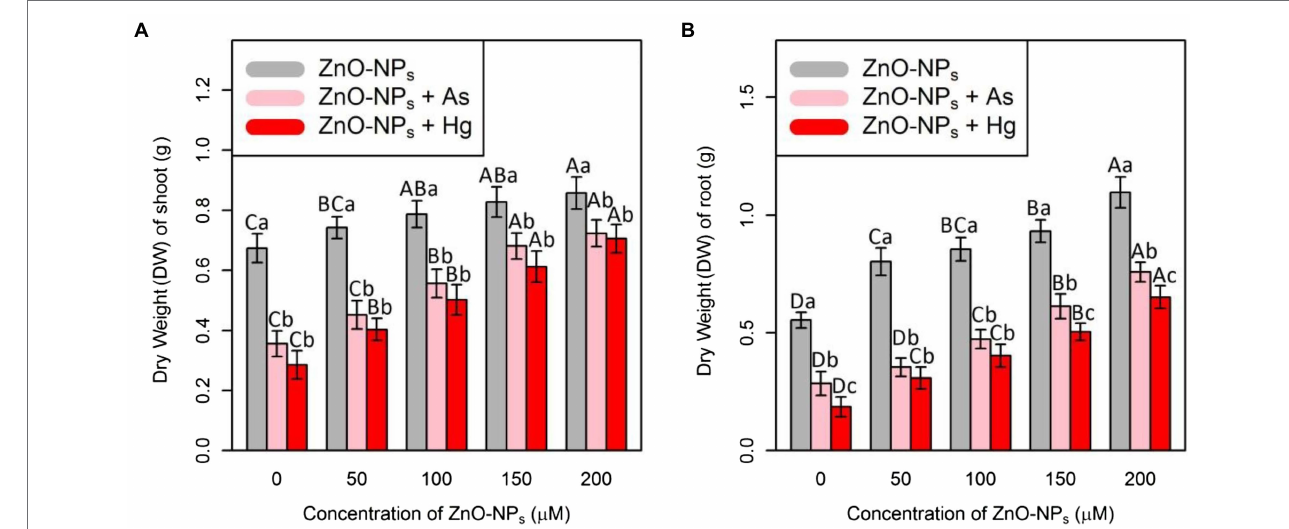
FIGURE 5 | The impact of ZnO-NPs concentrations on (A) dry weight (DW) of shoot and (B) dry weight (DW) of root in bamboo species ( Pleioblastus pygmaeus ) with 150 μ M As and 150 μ M Hg. The capital letters indicated statistically significant differences across various concentration of ZnO-NPs alone or in combination with 150 μ M As and 150 μ M Hg (the bars with the same colors), while the lowercase letters indicated statistically significant differences within each level of ZnO-NPs alone or in combination with 150 μ M As and 150 μ M Hg (the bars with different colors) according to Tukey’s test ( p < 0.05).